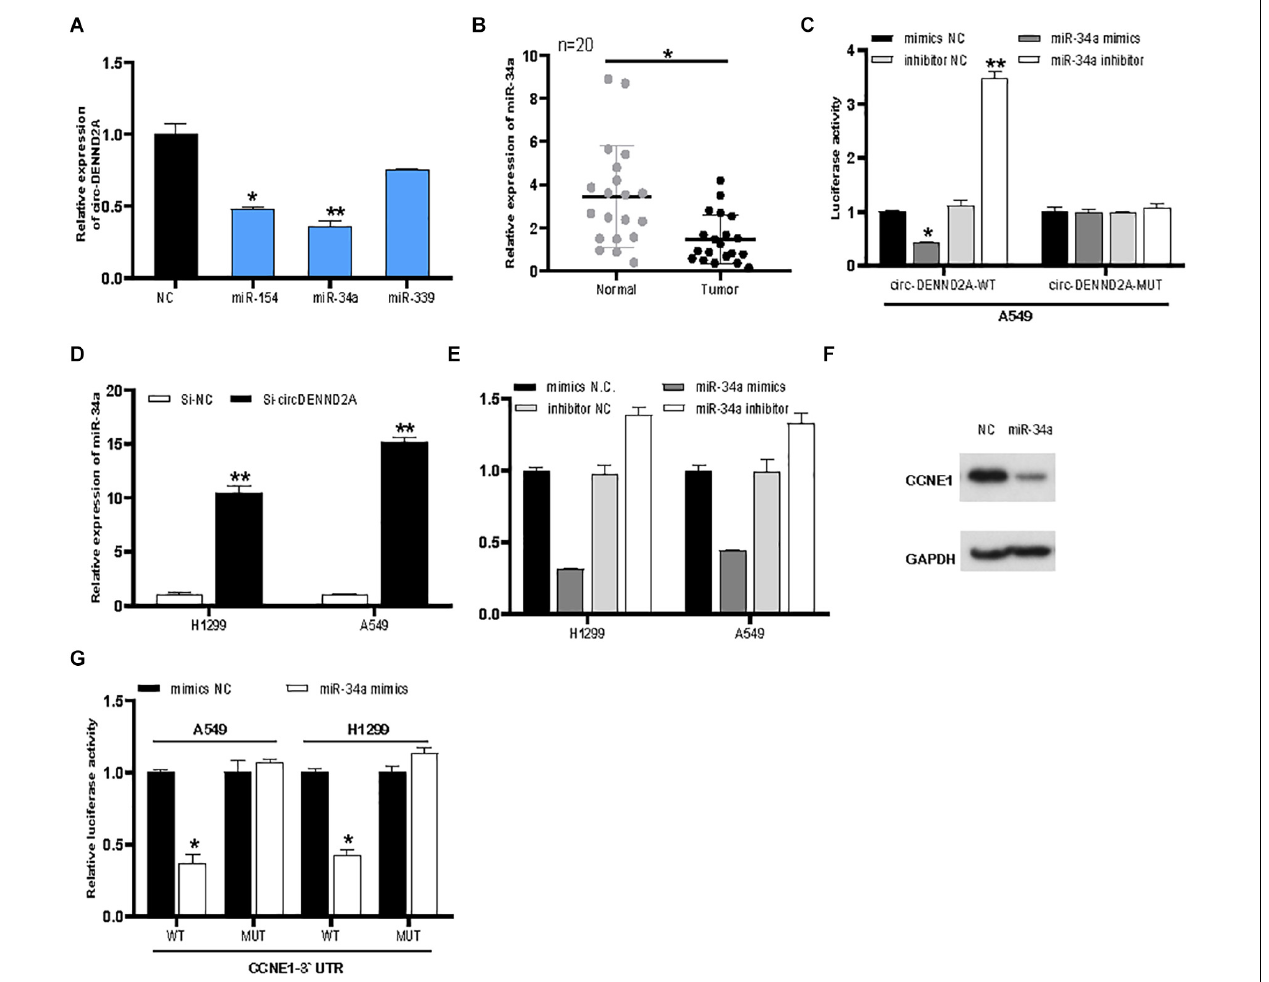
FIGURE 5 | CircDENND2A directly interacted with miR-34a and promoted CCNE1 expression. (A) CircDENND2A expression was detected after overexpression of miR-154, miR-34a, and miR-339. (B) The expression of miR-34a in tumor tissues was significantly down-regulated. (C) The relative luciferase activities were detected in the A549 transfected with the miR-34a or miR-34a inhibitors, reporter vector WT-circDENND2A, or MUT-circDENND2A. (D) The expression of miR-34a was inhibited in A549 and H1299 cells transfected with Si-circDENND2A. (E) The expression of CCNE1 was determined by qRT-PCR in A549 and H1299 cells transfected with NC, miR-34a inhibitor, and miR-34a mimics. (F) Western blot assay showed that miR-34a mimics could suppress CCNE1 level in A549 cells. (G) The relative luciferase activities were detected in the A549 transfected with the miR-34a or miR-34a inhibitors, reporter vector WT-CCNE1, or MUT-CCNE1 (* P < 0.05, ** P <